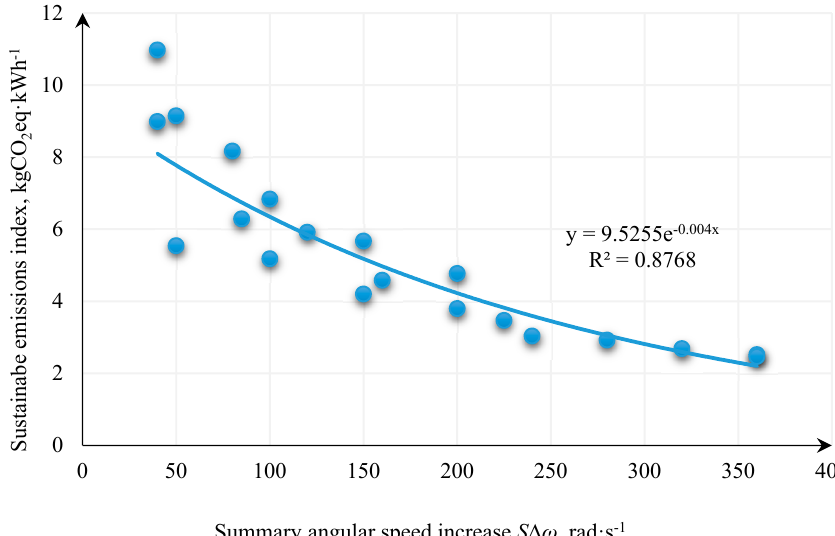
Figure 8. Sustainable CO 2 emissions index for rice grinding in a function of summary speed increase S ∆ ω .